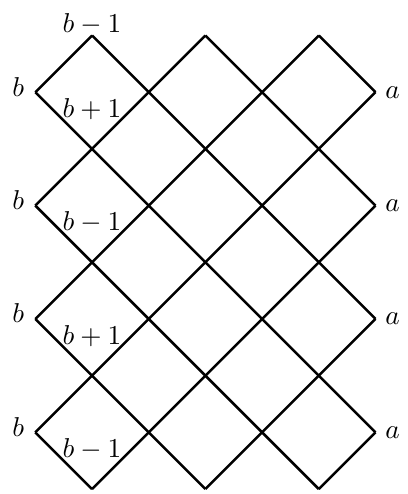
Figure 20 . Alternating boundary conditions in the antiferromagnetic RSOS model. We will write this boundary condition as b (cid:6) ; : : : ; a .